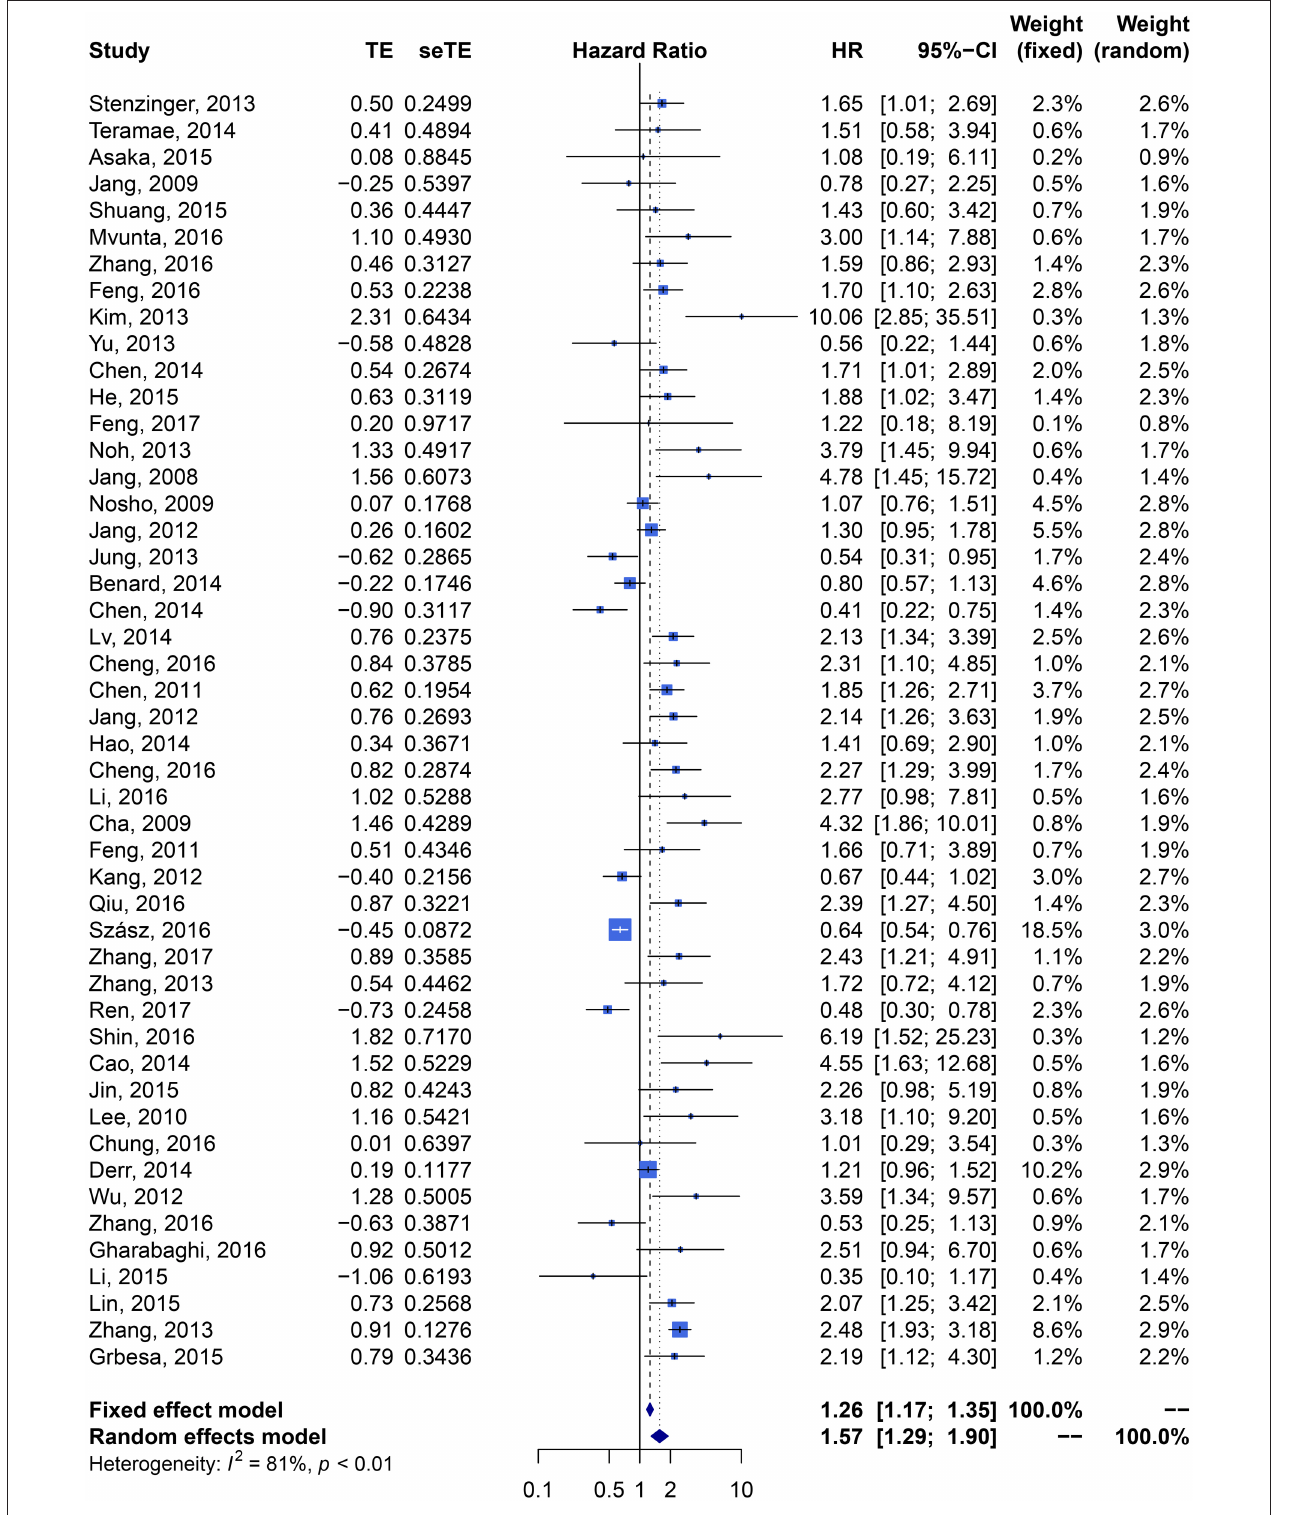
FIGURE 2 | Forest plot of SIRT1 expression and overall survival in various cancers.